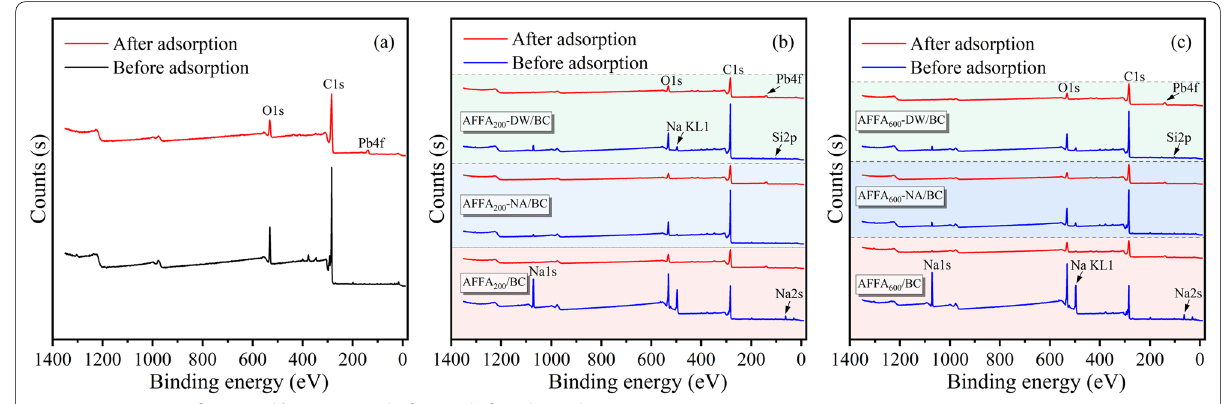
Fig. 7 XPS spectra of a BC and b , c AFFA/BC before and after Pb(II)